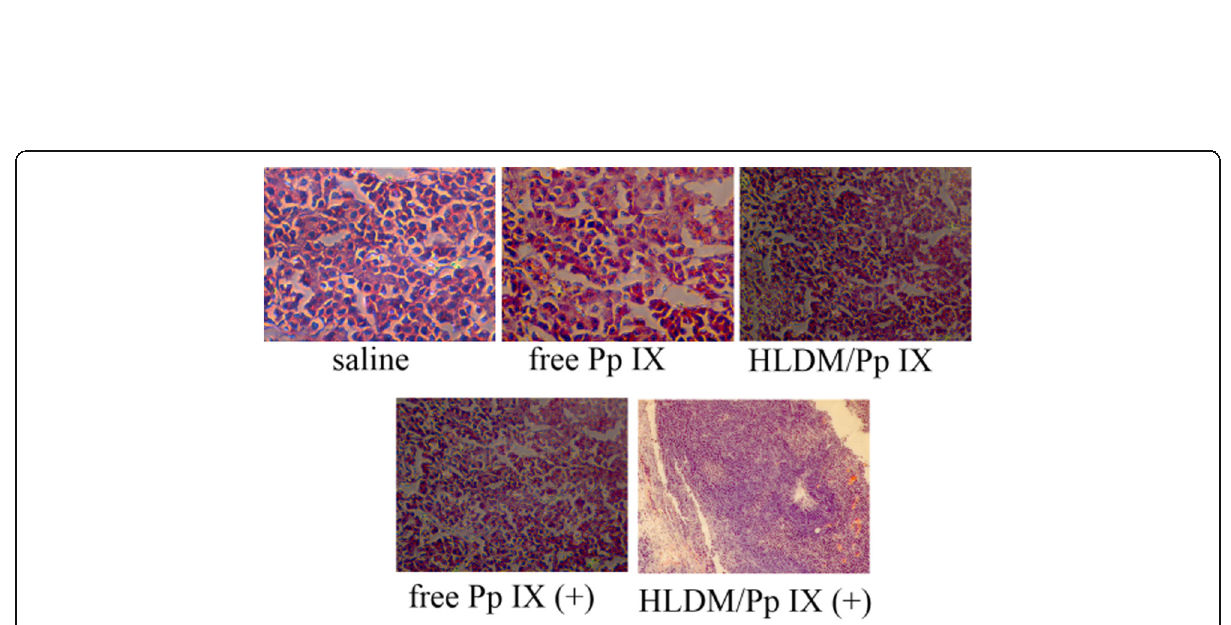
Fig. 11 H&E tumor staining with different formulations. All data are reported as a mean ± SD. n = 3; * indicates P <